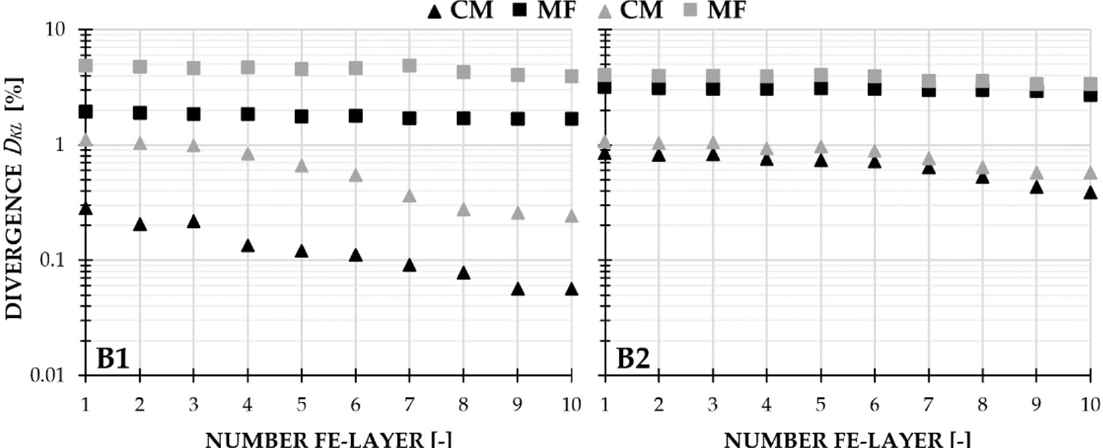
Figure 13. Kullback–Leibner divergences D KL of the fiber orientation tensors of the simulation A ij , CM , A ij , MF compared to the experiment A ij , CT of the PA66GF50 (black) and PPAGF50 (grey) on component level (B1–B2) and plotted over the number of layers of the FE-model.